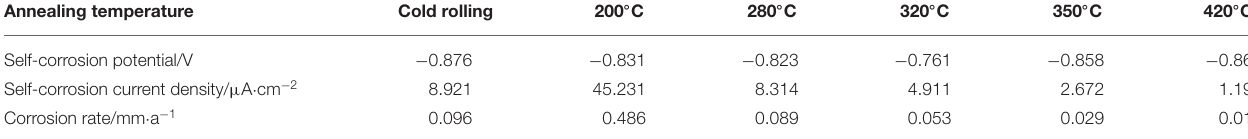
TABLE 2 | Fitting results of the polarization curves of the Sc-containing alloy samples annealed at different temperatures.